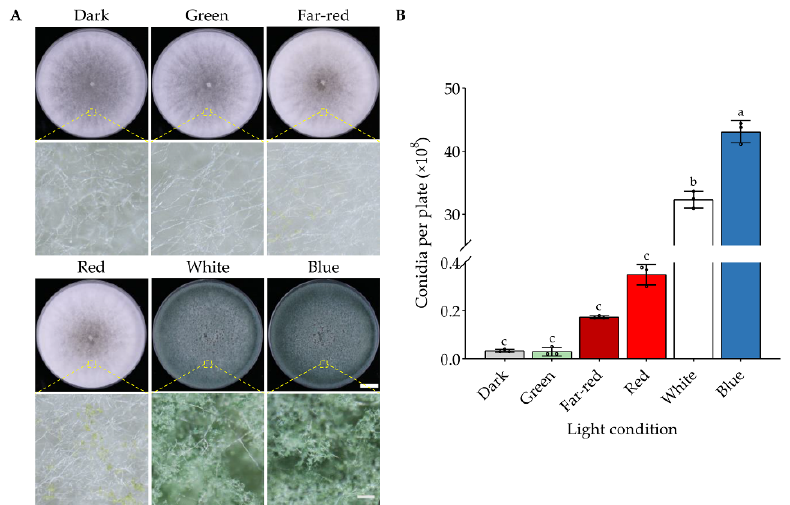
Figure 1. Effects of different wavelengths of light on T. guizhouense conidiation. ( A ) Phenotype of the wild type strain cultured under different wavelengths of light. The wild type strain was grown on PDA medium at 28 °C for four days. Scale bar, 1 cm. Colony surface was zoomed in under a stereoscopic micro-scope and the scale bar is 300 μ m. ( B ) Quantification of conidia produced under different wavelengths of light after four days of cultivation. The mean values for the three biological replicates are displayed. The error bar represents the standard deviation (SD) of three biological replicates. One-way ANOVA was used for the statistical analysis ( p ≤ 0.05). Means significantly different from each other do not share the same letter.